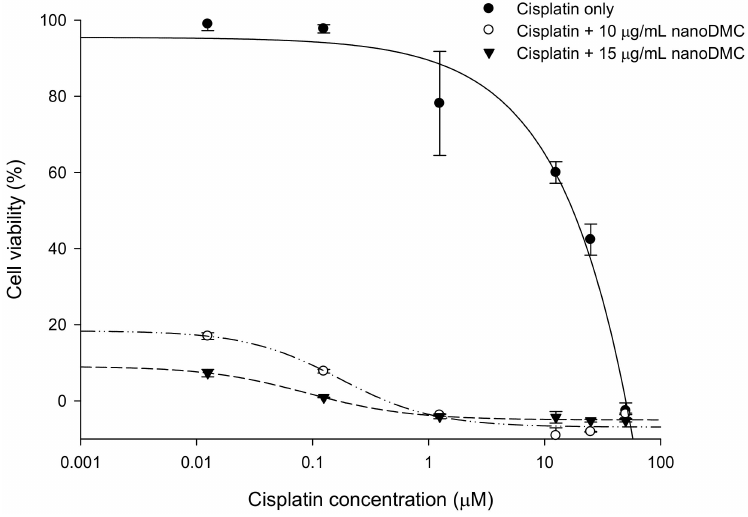
Figure 3. Effects of DMC-CHC NPs on cytotoxicity of cisplatin in A549